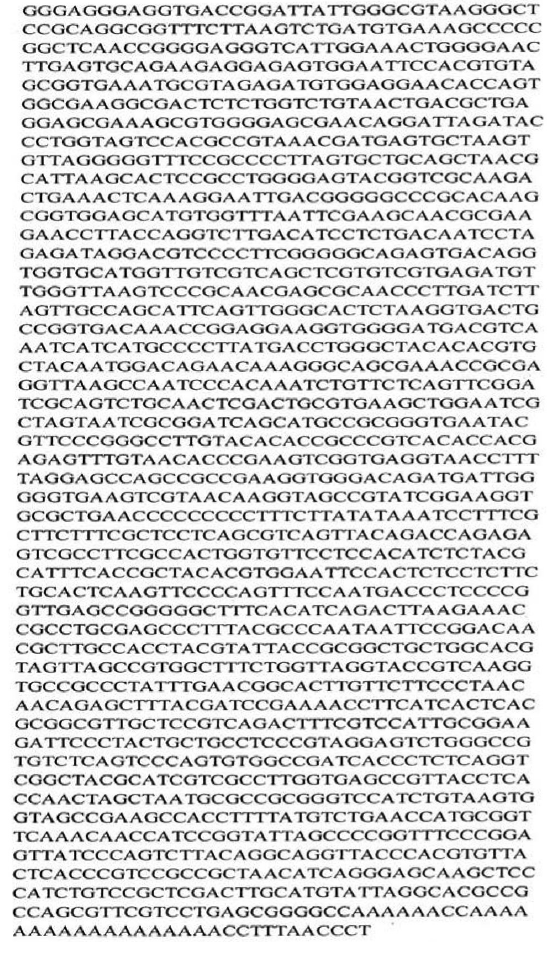
FIGURE 7 - The 16S rRNA sequence generated for isolate-4 had 1590 bases.